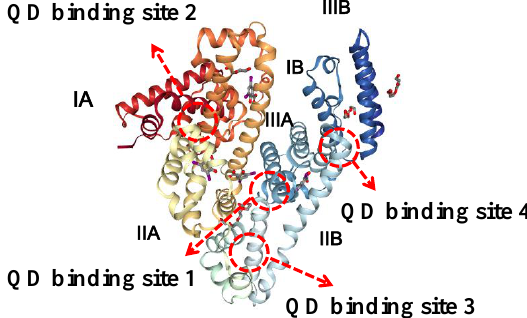
Figure S1: FCS correlation curves and hydrodynamic radius of QDs-COOH at different BSA concentrations (pH = 6.0) and BSA concentrations, Figure S2: FCS correlation curves and hydrodynamic radius of QDs-COOH at different BSA concentrations (pH = 9.0) and BSA concentrations, Figure S3: (a) FCS correlation curves and (b-d) Hydrodynamic radius of QDs-PEG at different BSA concentrations (T = 298 K) at different pH.